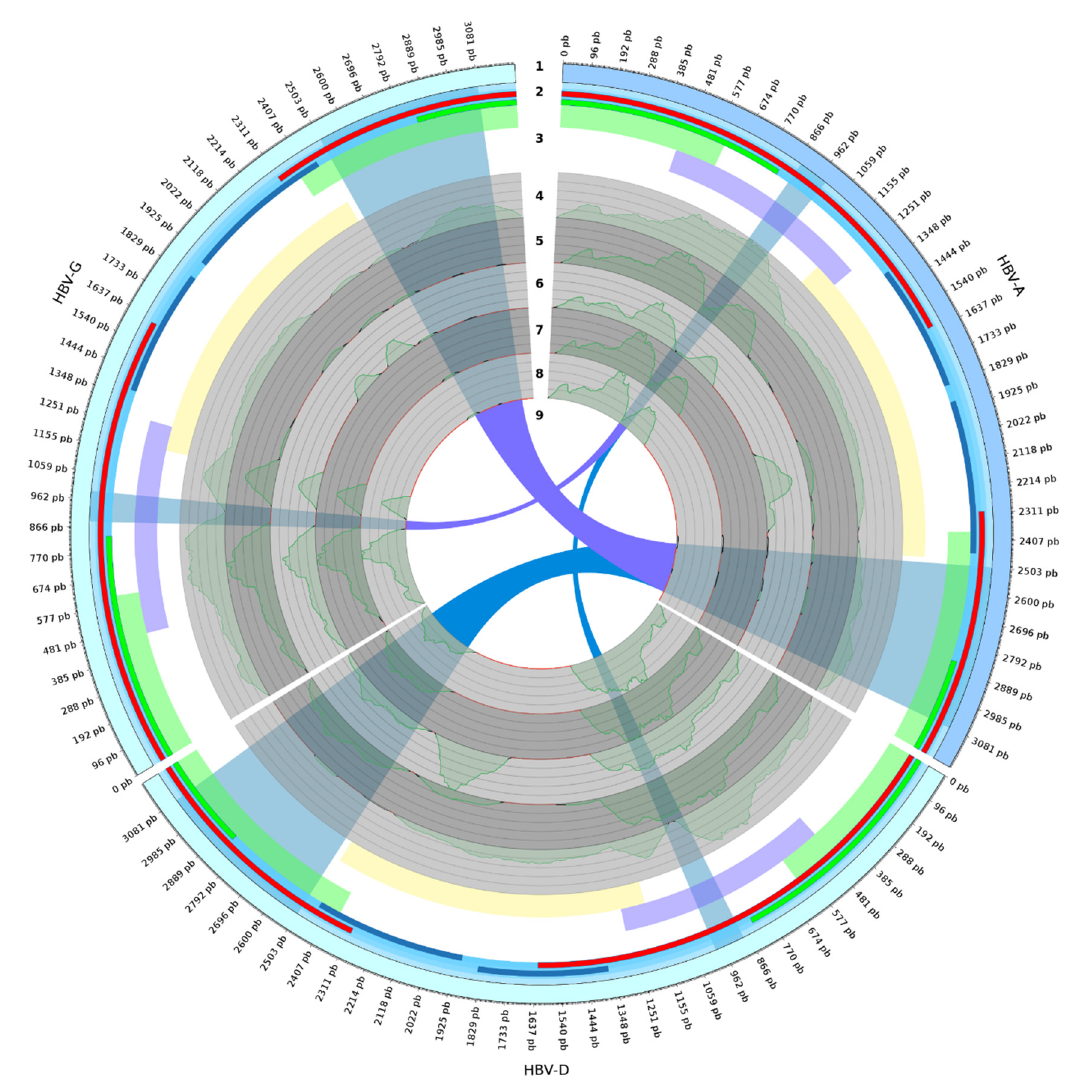
Figure 2. Diagram showing three HBV genotypes, amplicons, and mapping results. The 12 o’clock numbers in rings indicate ( 1 ) genome extension; ( 2 ) annotations, where red is the two regions of gene P (Polymerase; 2307–3215 nt and 1–1623 nt) and greens are the two regions of gene S (Gene PreS1, PreS2 and Gene HBsAg; 2848–3215 nt and 1–835 nt); ( 3 ) the three amplicon regions, where lightgreen, lightpurple, and lightyellow are the A, B, and C amplicons, respectively; ( 4 – 8 ) raw coverage ofread alignments from samples 1–5, respectively, where red, black, and green lines mean < 500, ≥ 500–2000, and ≥ 2000 reads mapped, respectively; ( 9 ) links between homologous regions with differential coverage among genotypes.